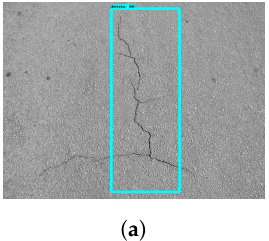
Figure 15. Defect detection results for Fan Yang cracks dataset in ( a – d ).